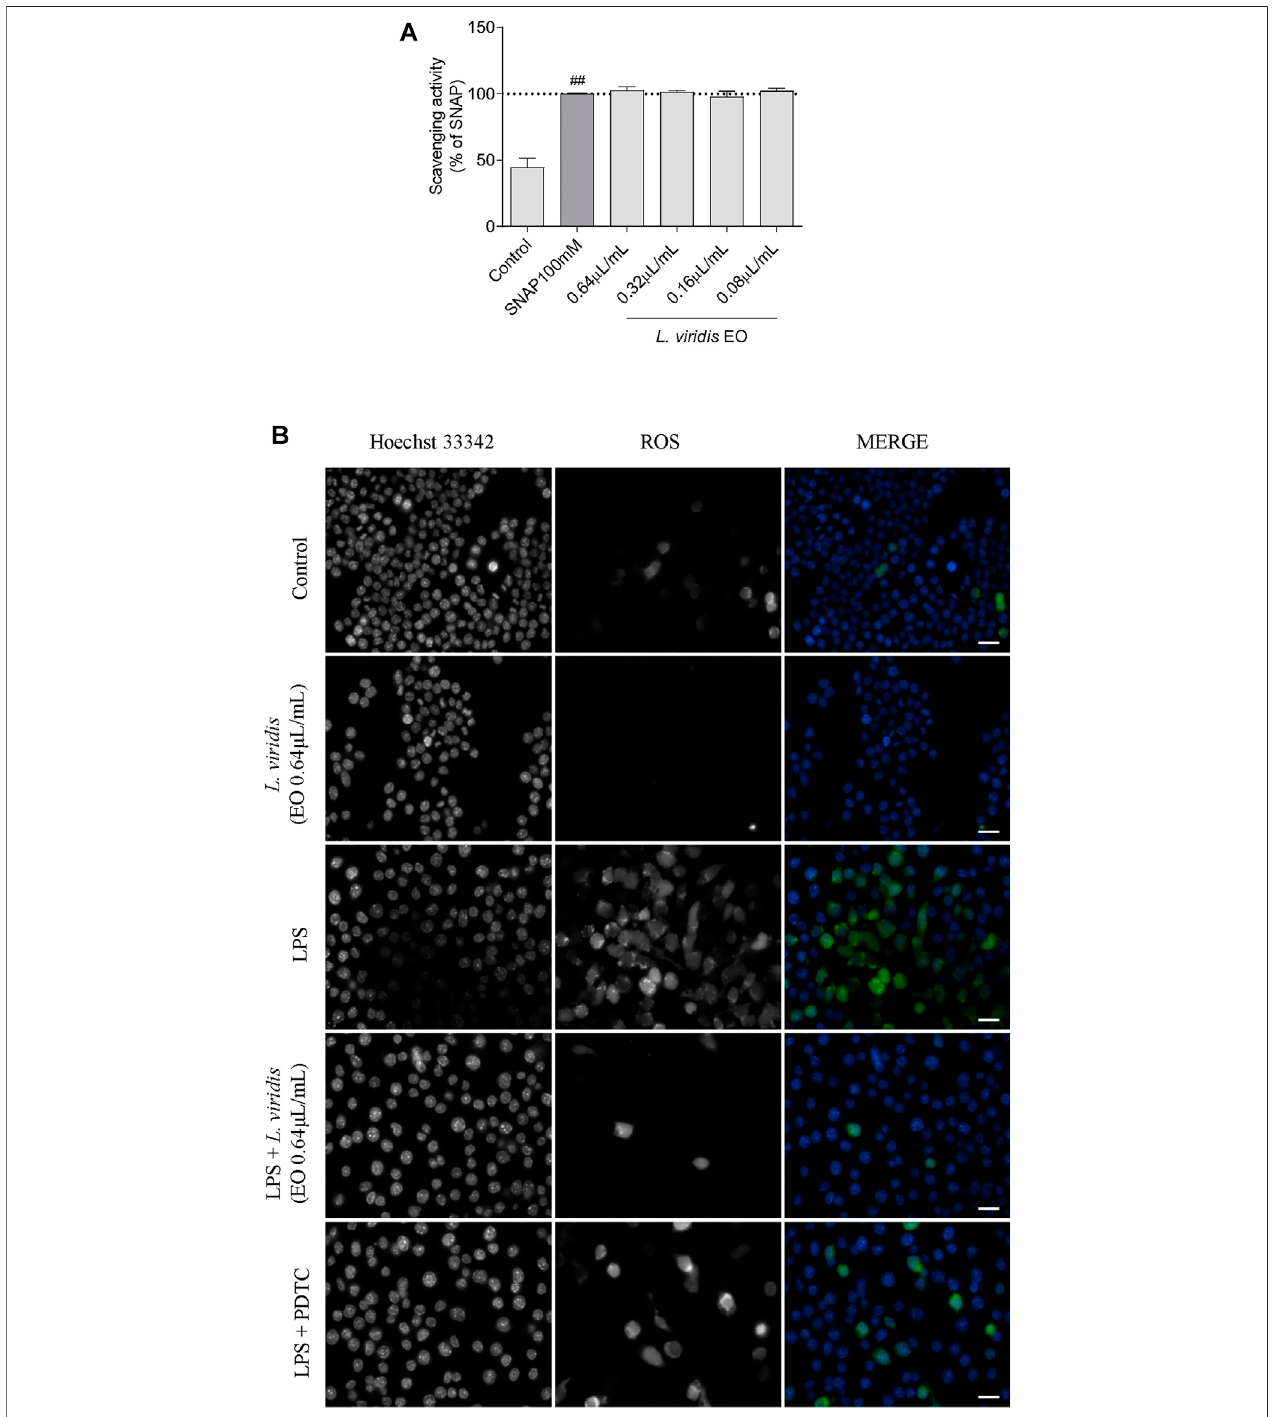
FIGURE 3 | Antioxidant potential of L. viridis L´Hér. essential oil (EO): (A) Effect on reactive nitrogen species (RNS) assessed though a nitrite-scavenging assay. Differentconcentrationsofthe essentialoil wereincubated withthe NOdonor,SNAP (100 mM),inculturemedium for3 h. Results areexpressed asapercentage ofNO releasebySNAP.Eachvaluerepresentsthemean ± SEMfromthreeexperiments,performedinduplicate.StatisticaldifferencesbetweencontrolandSNAPgroupswere calculatedusingtwo-sidedunpaired t -test(### p < 0.001,comparedtocontrol). (B) Immuno fl uorescenceanalysisoftheeffectof L.viridis L´Hér.onreactiveoxygen species (ROS) production. Macrophages were incubated on μ -slides and treated as detailed in the methods section. PDTC was used as a positive control and Hoechst 33342 used as counter stain. The images were acquired with an Axio Observer.Z1 inverted fl uorescence microscope (Zeiss). Scale bar: 20 µm.